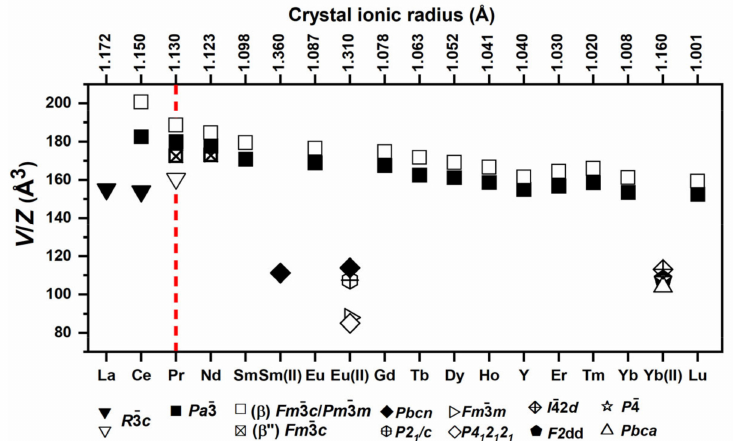
Figure 2. Unit cell volumes (V) of the reported rare earth borohydrides divided by the number of formula units (Z) [391,392,395,396,399,400,402–407] are presented. The ionic crystal radius were taken from [388]. The high-temperature polymorphs are displayed with empty signs. The figure was adapted from [408] with permission from The Royal Society of